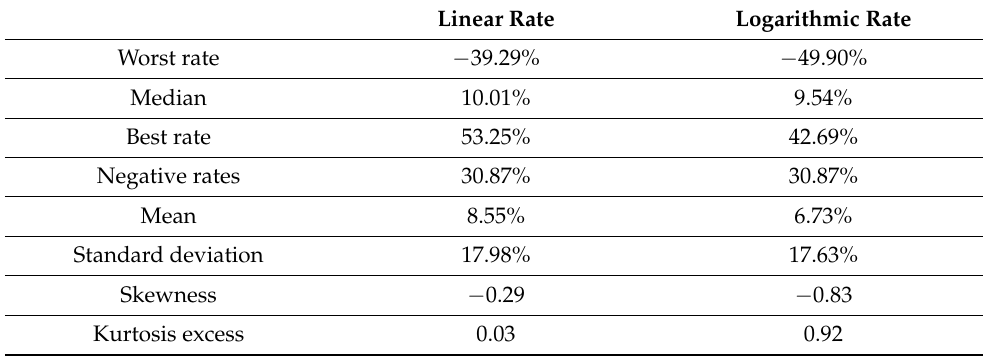
Table 2. Annual real rates of return, 1872–2020.